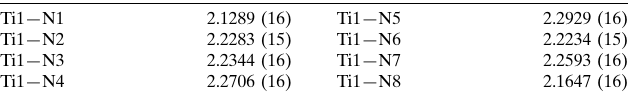
Selected bond lengths (A˚